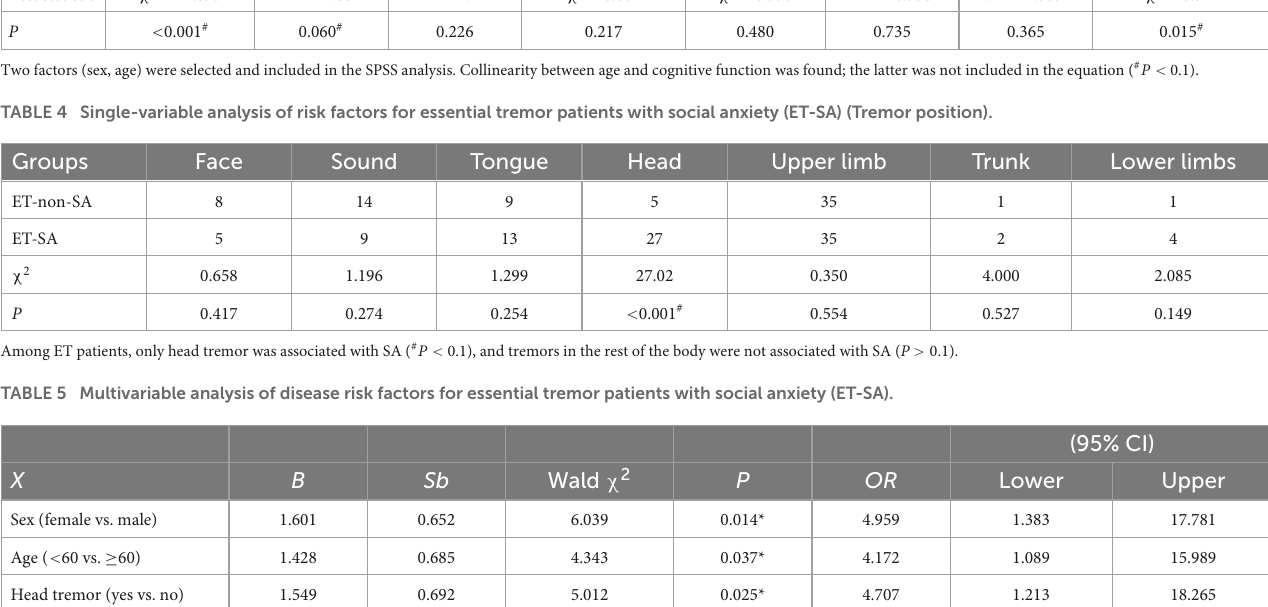
TABLE 3 Single-variable analysis of risk factors for essential tremor patients with social anxiety (ET-SA) (General). Groups